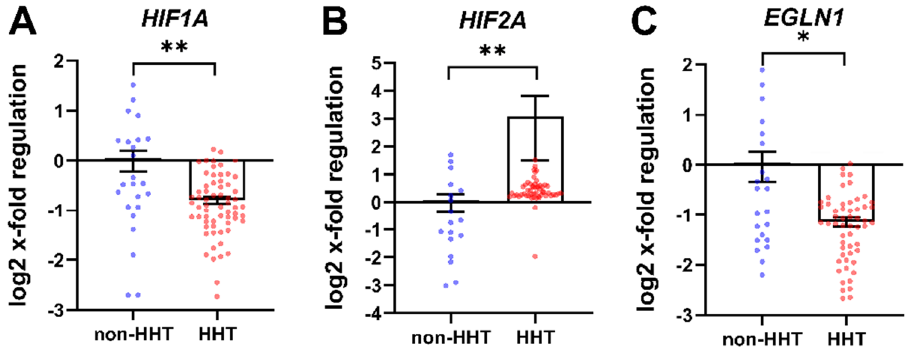
Figure 1. Hypoxia related gene transcription of whole blood in HHT compared to non-HHT controls. Patients with HHT showed decreased HIF1A ( A ) and increased HIF2A ( B ) gene expression. The HIF-1α target gene EGLN1 ( C ) is significantly decreased in HHT patients. Data are presented as log2 x-fold regulation in mean ± SEM. The Mann Whitney U test was used to compare the groups, *p < 0.05, **p < 0.01. n (non– HHT) = 26, n (HHT) = 66).